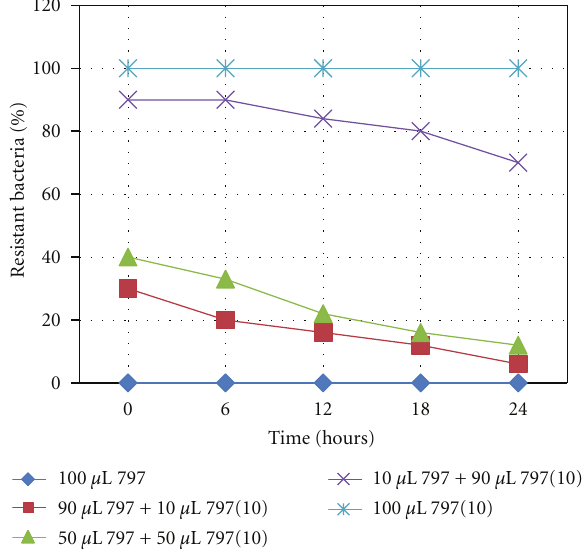
Figure 1: Plot of resistant bacteria after competition between sus- ceptible 797 and resistant 797